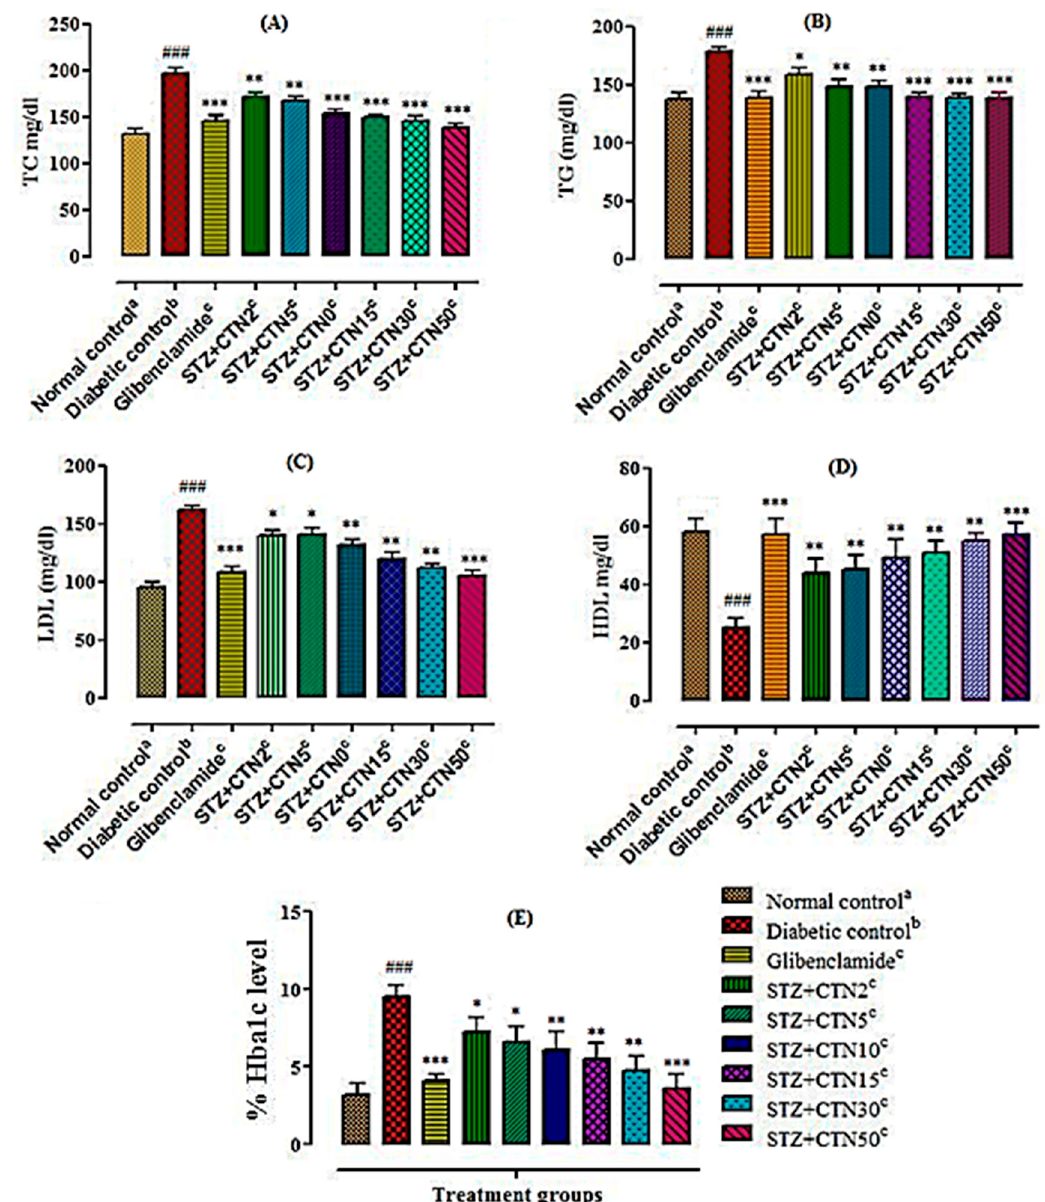
Figure 4. Effects of catechin on the level of serum lipid parameters and Hb1c level in STZ-induced diabetic rats ( A ) Serum level of TC, ( B ) serum level of TG, ( C ) serum level of LDL, ( D ) serum level of HDL, ( E ) serum level of Hb1c in STZ-induced diabetic rats. The values are expressed as mean ± SEM. Each value corresponds to a mean of eight animals ### p < 0.001; comparison of a (normal control) vs. b (diabetic control) using Student’s t-test, * p ˂ 0.05, ** p ˂ 0.01, *** p < 0.001; comparison of b (diabetic control) vs. c (glibenclamide and CTN treated groups) using one way ANOVA followed by Dunnett’s post hoc multiple comparison test.